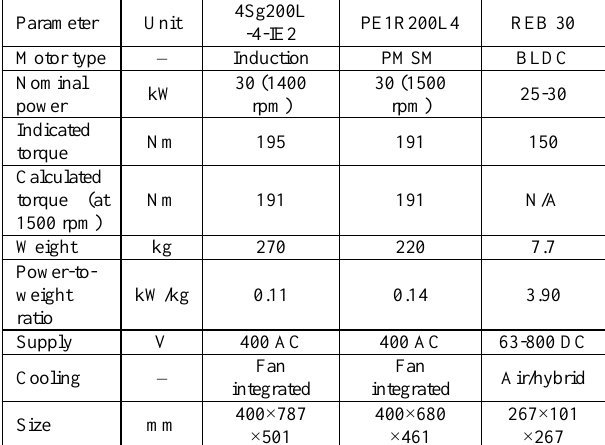
Table 2. Parameters of selected electric motors [12, 23,